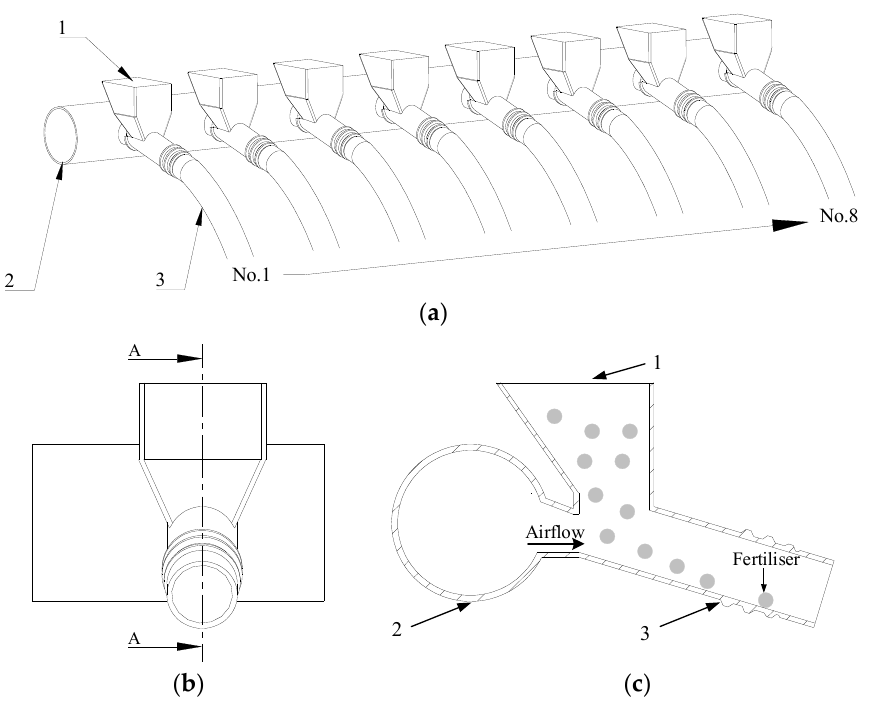
Figure 1. Pneumatic conveying line used in side-deep fertilisation devices for rice paddies. (1) Feeding port for the fertilisers; (2) Airflow inlet to the duct; (3) Branch pipe No. 1. The branch pipes are numbered 1–8 from left to right; ( a ) Axonometric drawing of the line; ( b ) Front view of a branch pipe; ( c ) A–A section view.